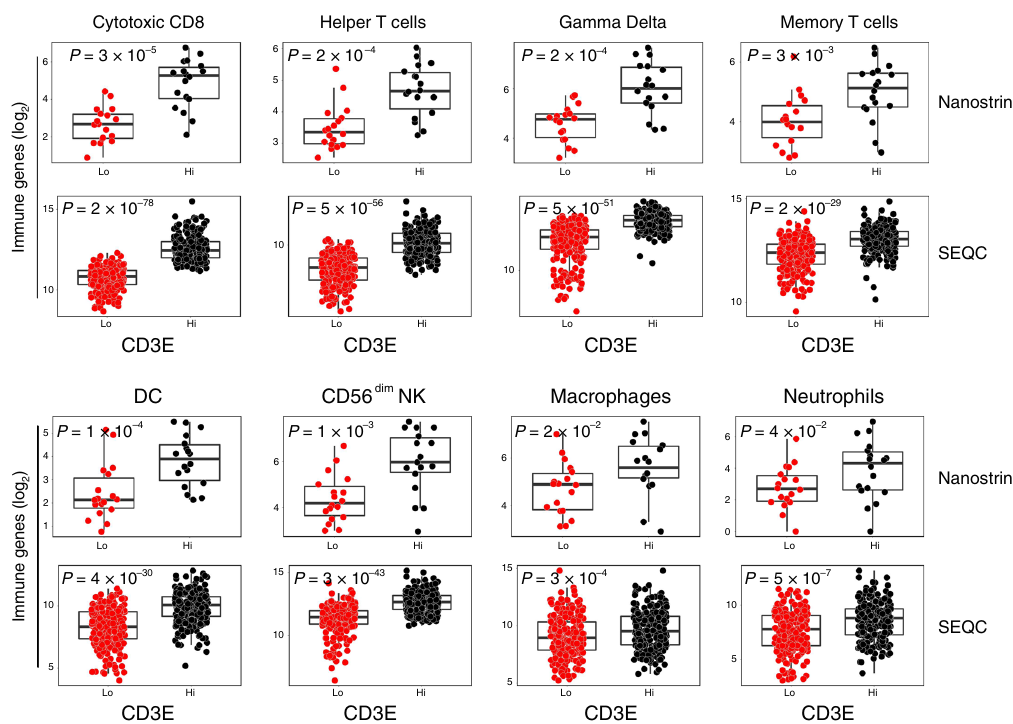
Fig. 2 Intratumoral DCs and NK cells correlate with CD3E gene expression in human neuroblastoma. Box plots of metagene expression values for the indicated immune cell types 28 according to the high (Hi) and low (Lo) levels of CD3E mRNA (median split) in primary NB patients from Nanostring-NB ( n = 36) and the SEQC-NB ( n = 498) cohorts. The immune cell type scores were calculated as the average expression values of the NanoString constituent genes. The boxes show the 25th to 75th percentile; the horizontal lines inside the box represent the median; the upper whisker extends to the largest data point, no more than 1.5 times the IQR from the box; the lower whisker extends to the smallest data point at most 1.5 times the IQR from the box; the dots are individual samples. Data were analyzed by Kruskal – Wallis rank-sum test (two-sided). No adjustment was required. Statistically signi fi cant P values are